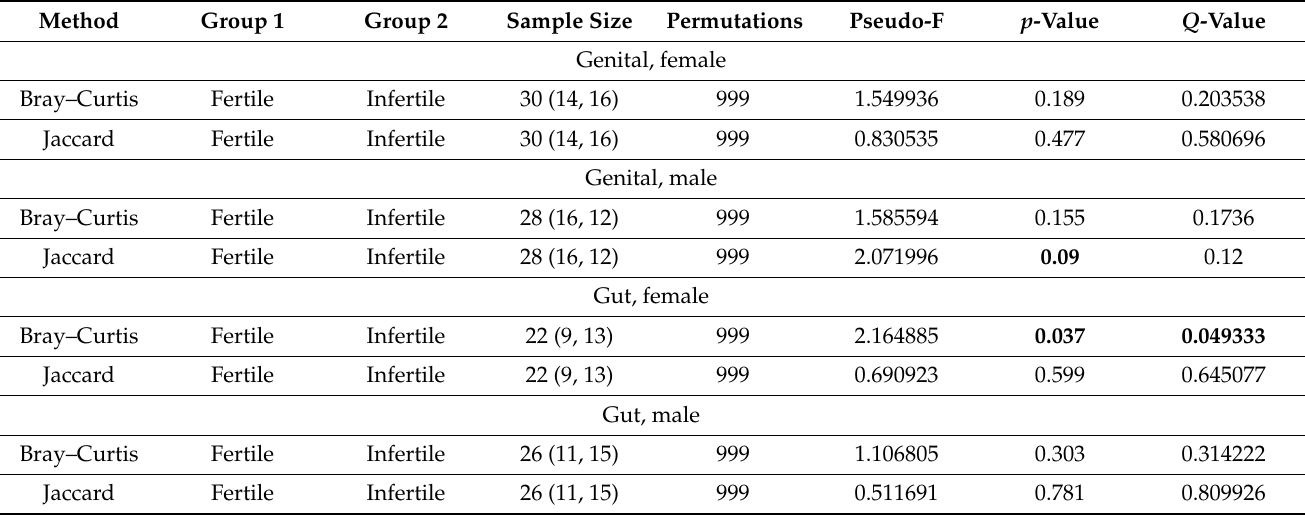
Table 10. Differences in the beta-diversity of MetaCyc pathways between samples. (PERMANOVA, <0.1 are in